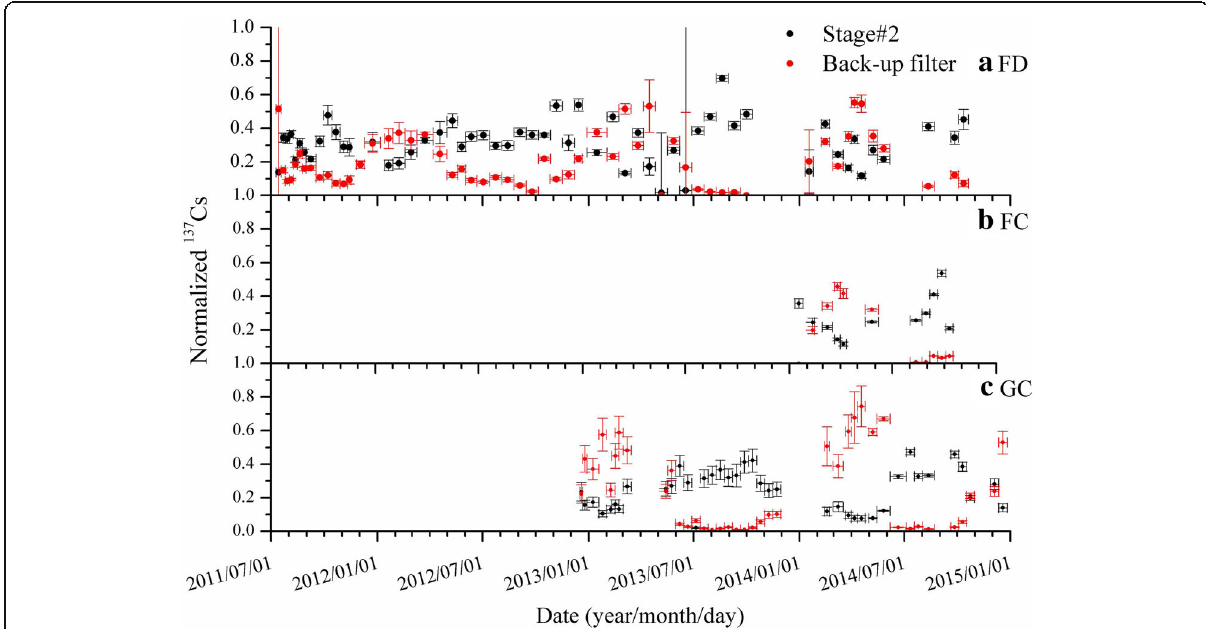
Fig. 4 Time series of the normalized 137 Cs (2) and 137 Cs (7) measured at the ( a ) FD, ( b ) FC, and ( c ) GC sites. These results clearly showed the seasonal variation but did not accurately reflect the size distribution of radiocesium in the atmosphere because of the bouncing particles. The amount of bouncing particles significantly changes the collection efficiency of the cascade